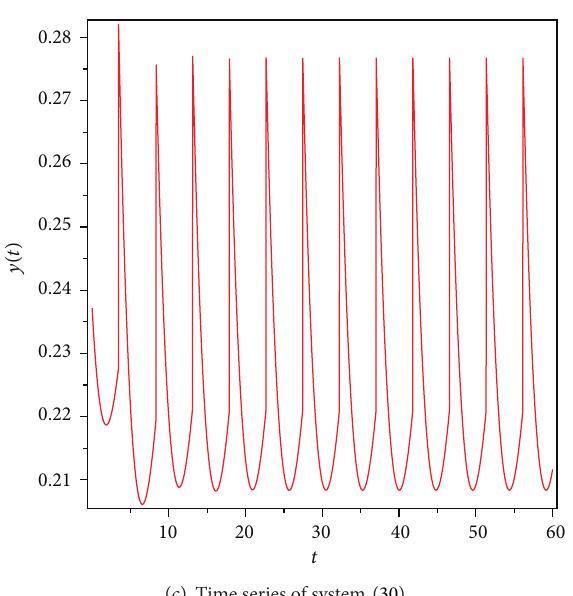
Figure 10: There exists a 1-periodic solution in the area Ω 1 = {(𝑥,𝑦) | ℎ 1 < 𝑥 < ℎ 2 } corresponding to Figure